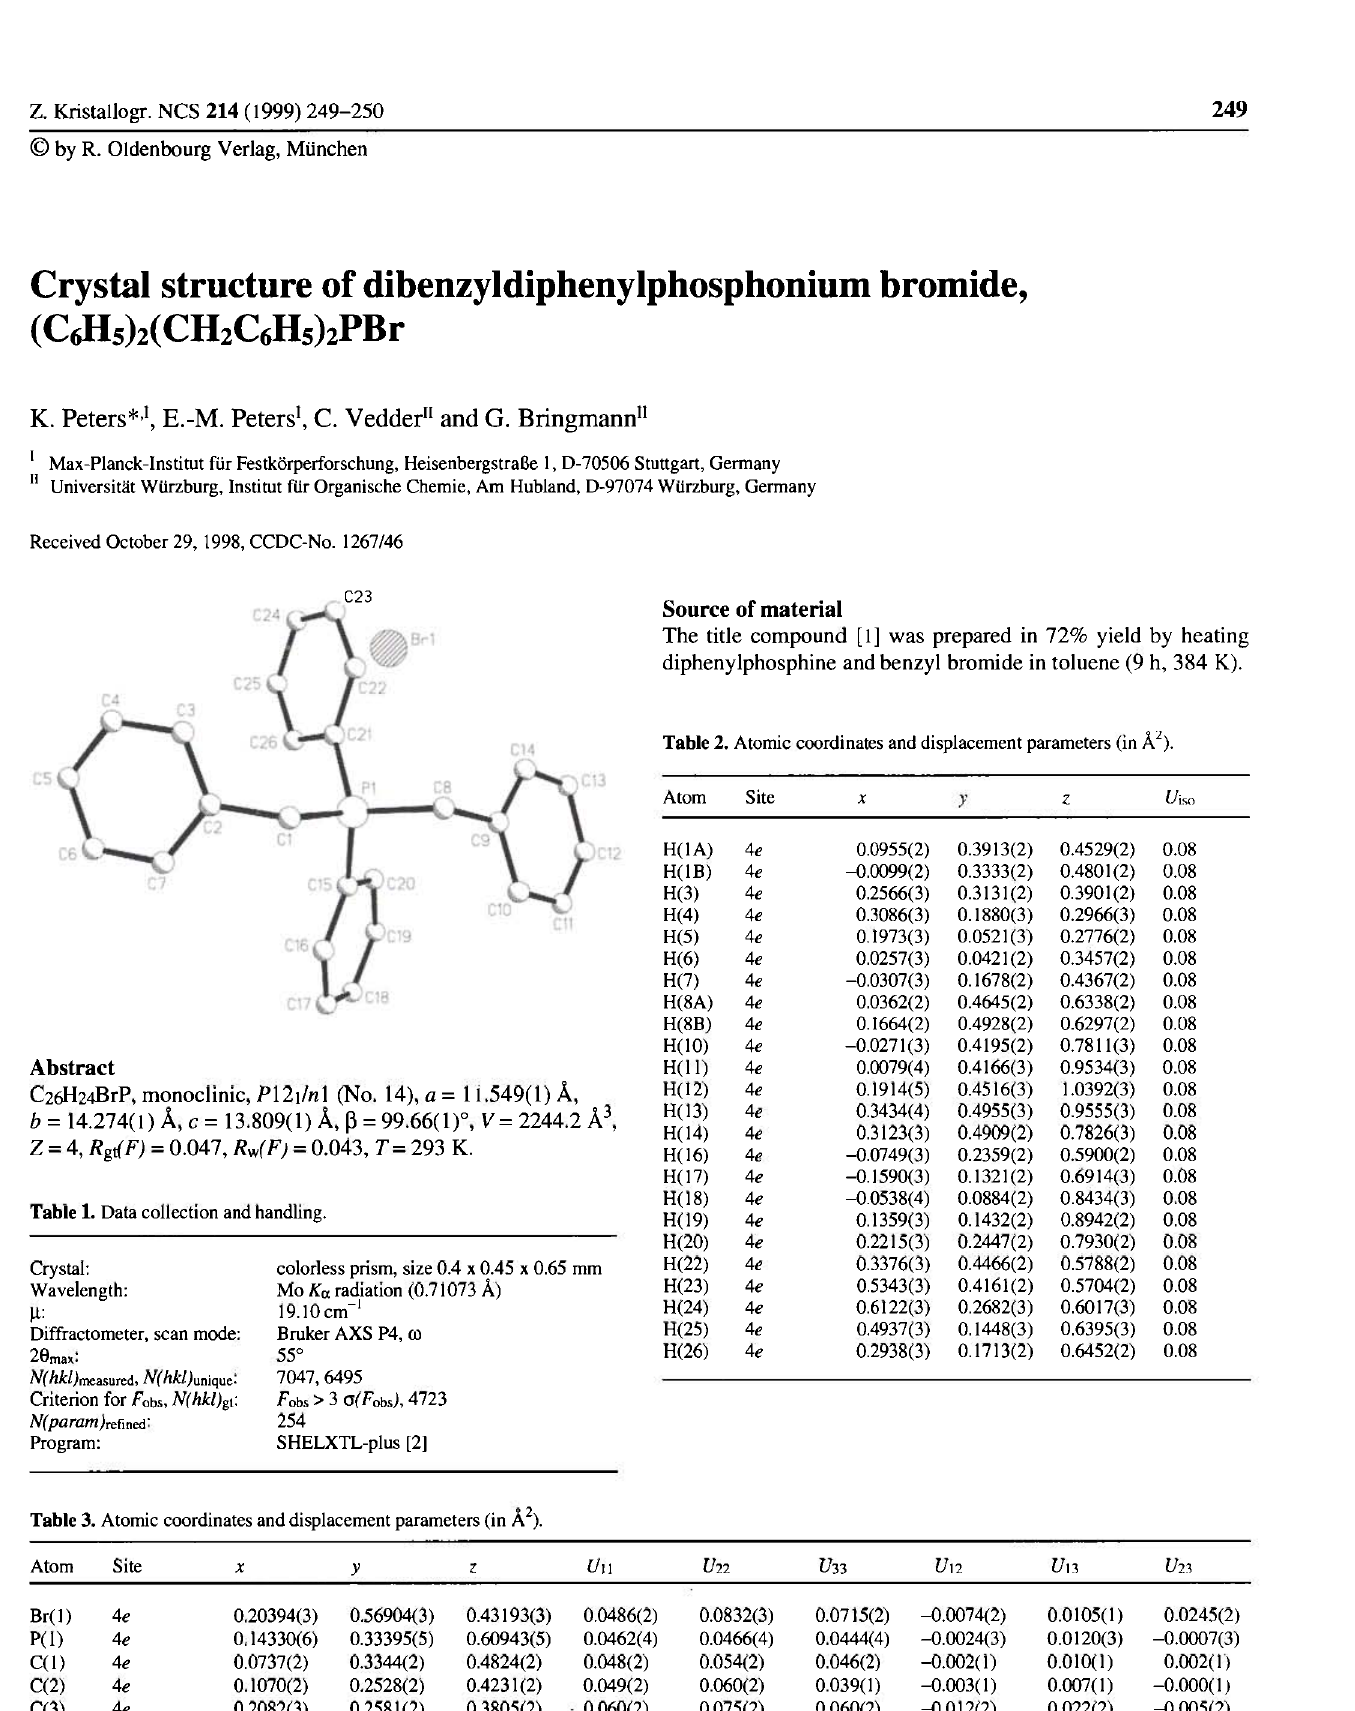
Table 2. Atomic coordinates and displacement parameters (in Ä ).